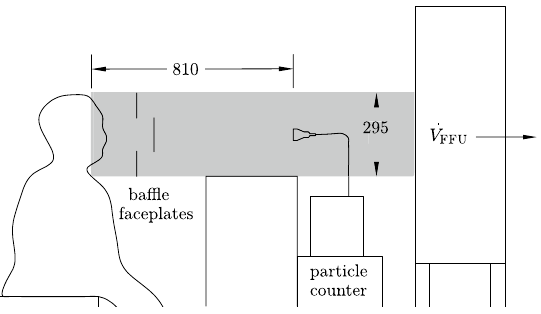
Figure 5. Schematic test setup with one person in cleanroom clothing whose exhaled air was recorded by the particle counter. The glass measuring section (gray colored area) was located on the suction side of a horizontally positioned Filter Fan Unit (FFU). All geometric dimensions are in mm (Figure adapted from Fig. 2 in Hartmann et al. 26 ). (Figure created with cairo 1.15.10, http:// cairo graph ics.